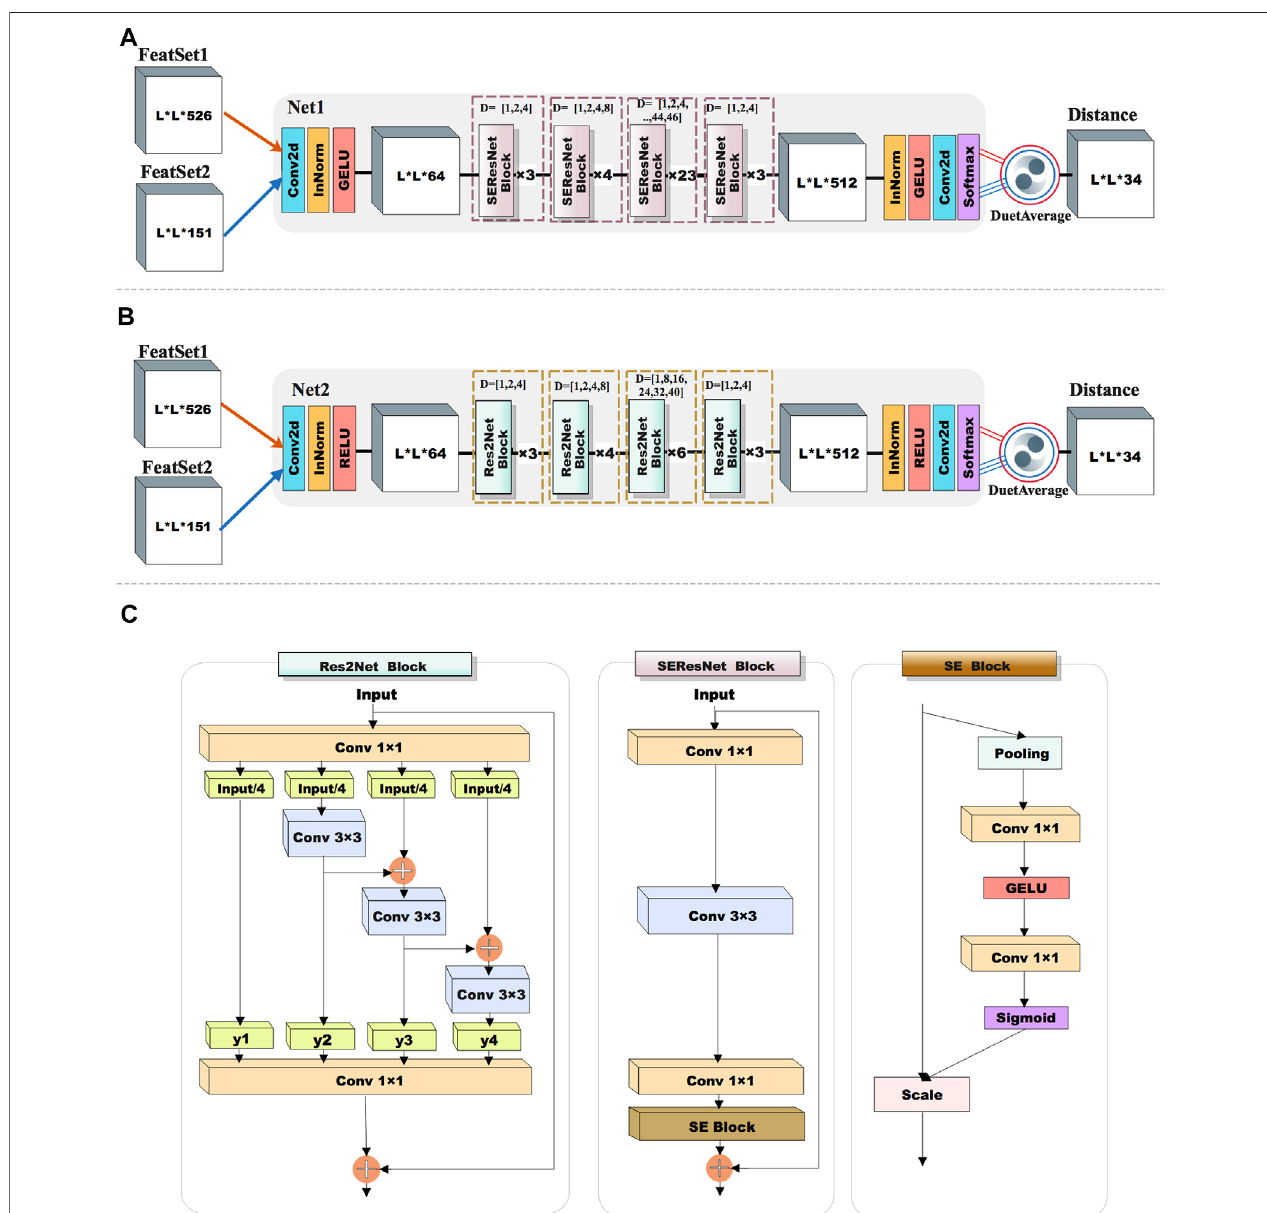
FIGURE 2 | The network architecture used in this work. (A) The network used by DuetDis; (B) the reference network; (C) basic modules used in the networks; dilated convolution.